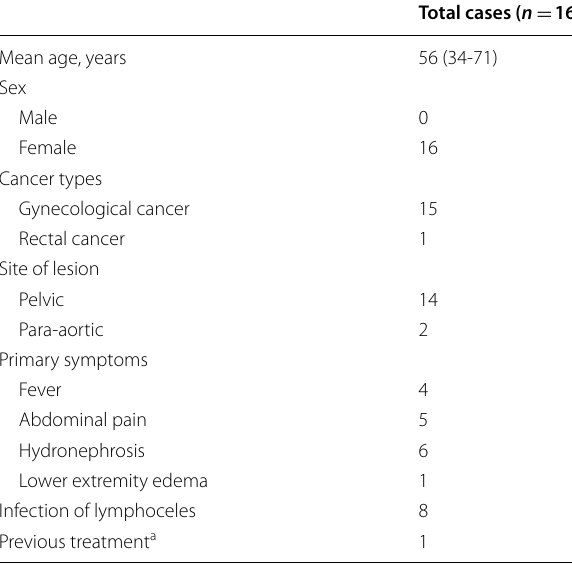
Table 1 Characteristics of the